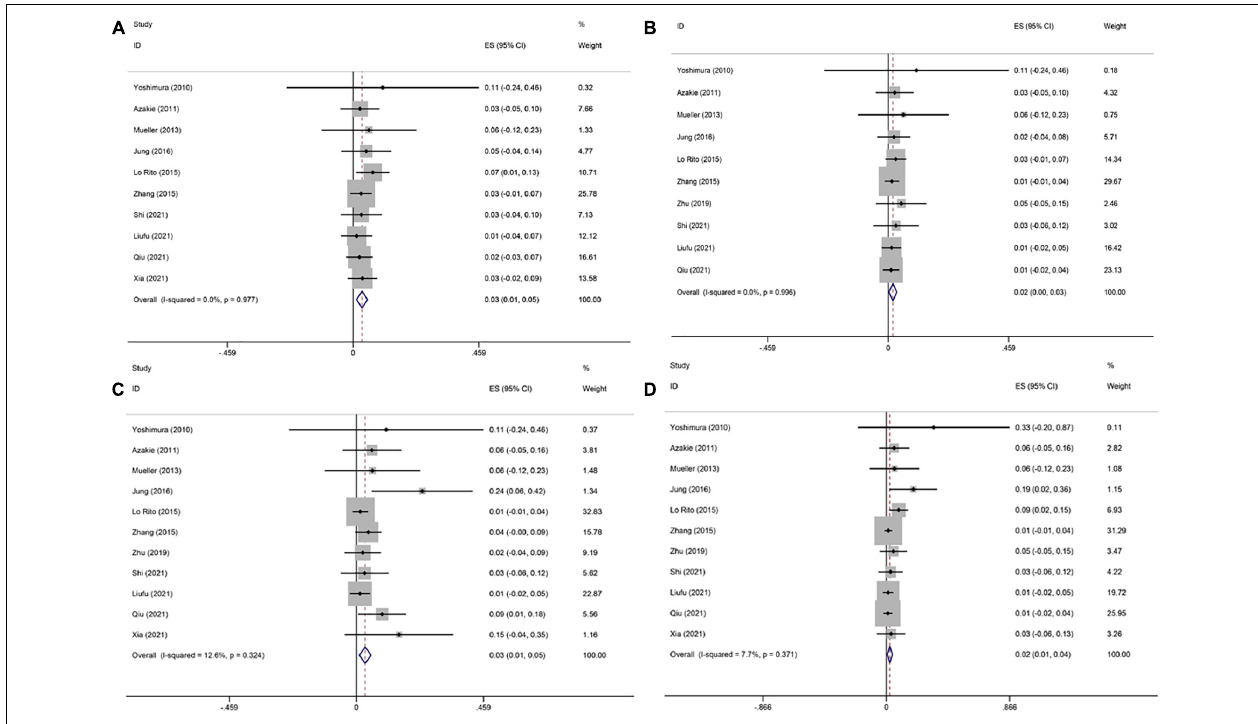
FIGURE 3 | Forest plots of postoperative pulmonary venous obstruction (PVO), early and late mortality, and reoperations due to PVO after sutureless technique. (A) Forest plot of incidence of postoperative PVO. (B) Forest plot of reoperations due to PVO. (C) Forest plot of early mortality. (D) Forest plot of late mortality. TABLE 2 | Subgroup analysis of primary outcomes in patients with TAPVC following sutureless repair based on single-arm analysis. Primary outcomes Subgroups Studies ( n ) Pooled estimate (95% CI) Heterogeneity ( I 2 ) P -value P for interaction Postoperative